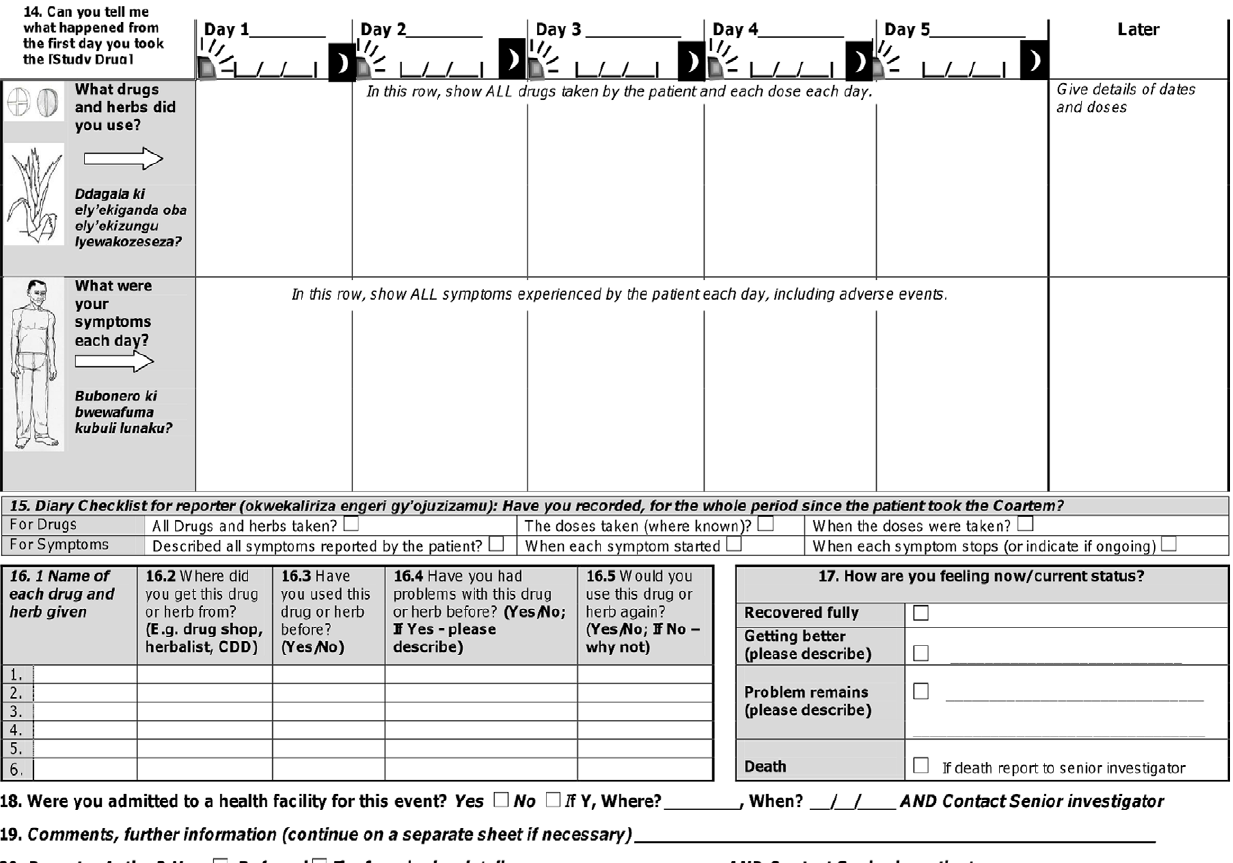
Figure 5. Final draft of passive reporting form for adult patient (Page 2).